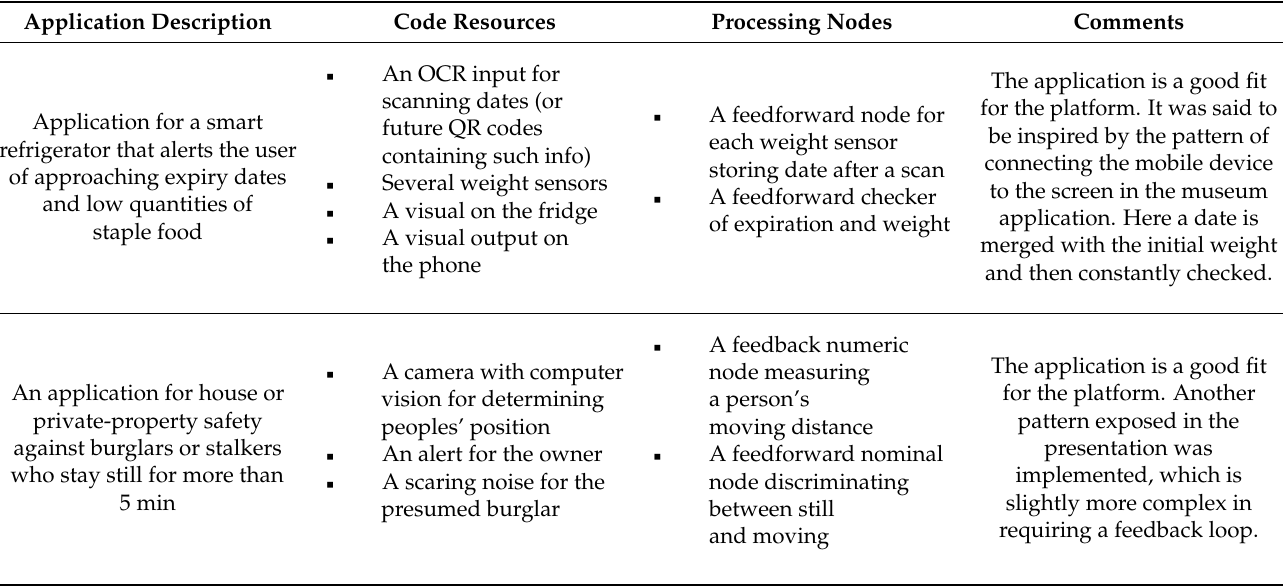
Table 3. Applications that are imagined and designed by non-programmers.